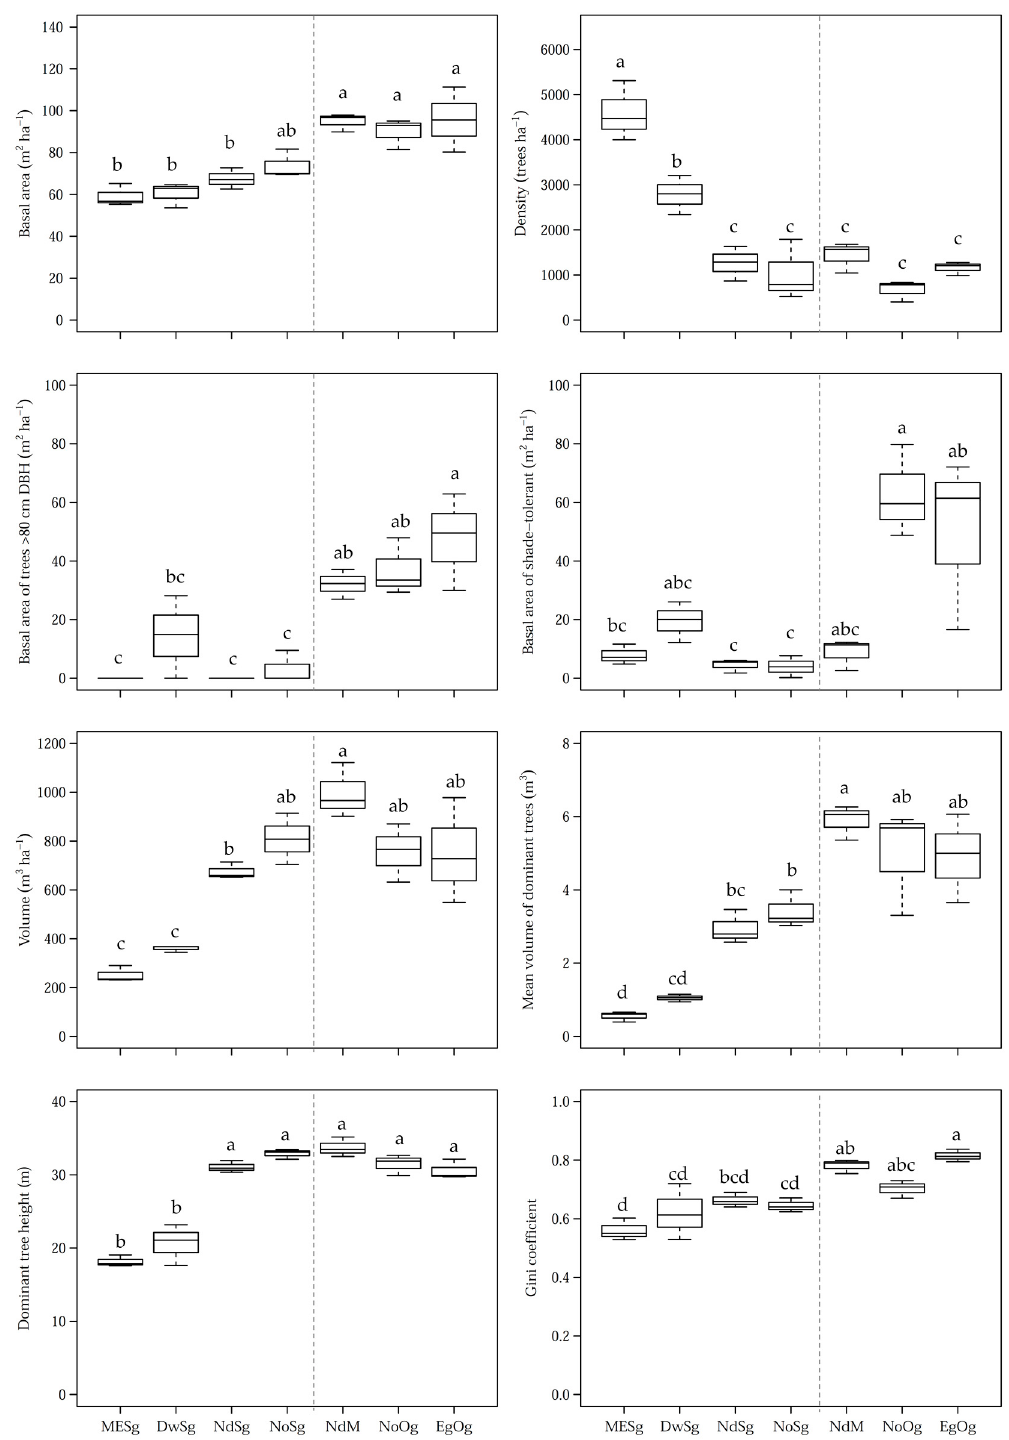
Figure 2. Distribution of the most characteristic differential variables among the sampled forests. Different letters within each row represent significant differences ( p -value < 0.05). The middle bar corresponds to the median. Dashed lines separate successional forests from mature and old-growth forests.